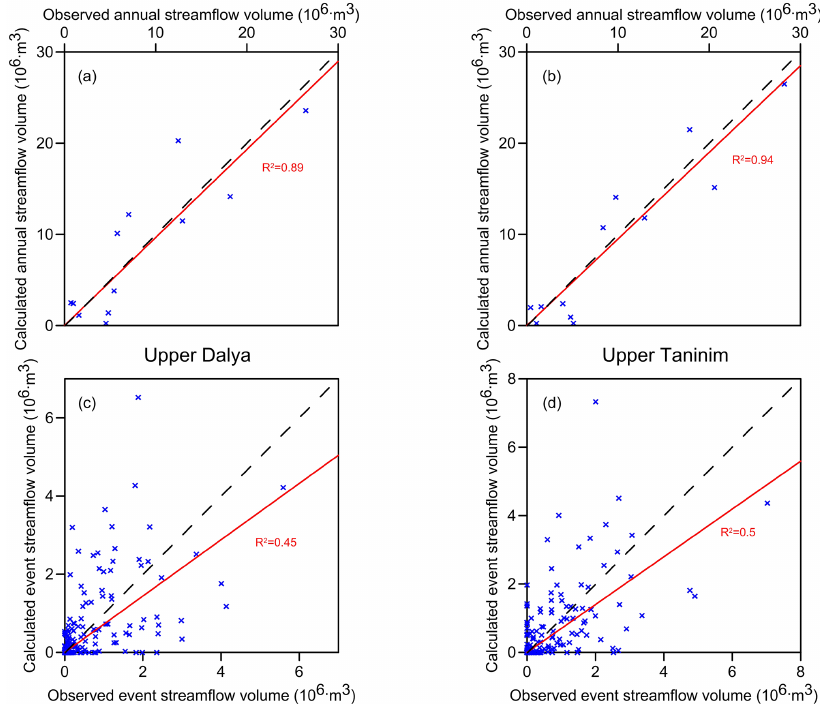
Figure 3. Panels (a) and (b) present calculated (from SAC-SMA) vs. observed (from hydrometric stations) annual streamflow volumes for the upper Dalya and upper Taninim catchments, respectively, for 12years of data. The R 2 values relate to the linear fit that runs through the origin (red line). Dashed line represents perfect match between observed and calculated volumes (slope of 1). Panels (c) and (d) are the same but for event streamflow volumes.